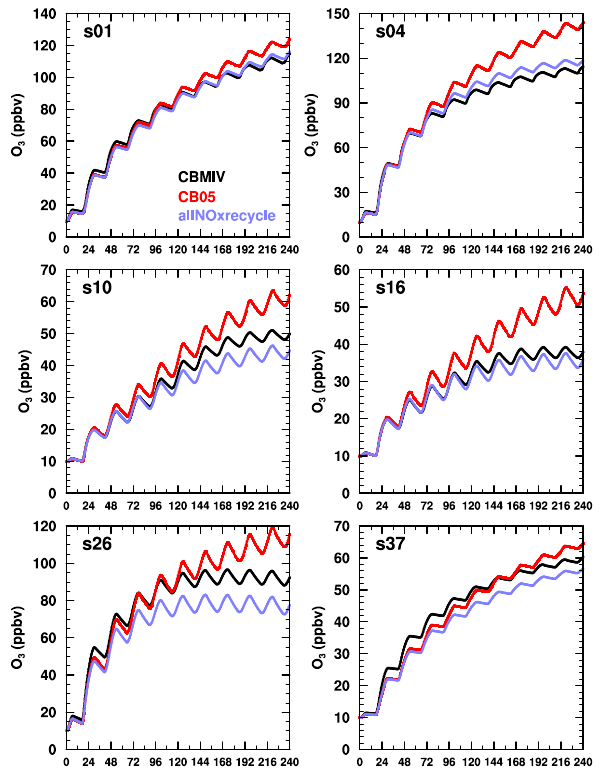
Figure 9 . Example scenario results for sensitivity test xNTRrecycle . Ozone mixing ratios 2 Fig. 9. Example scenario results for sensitivity test xNTRrecycle. (ppbv) for the base CB05 (red), base CBMIV (black) and sensitivity test xNTRrecycle (violet) 3 Ozone mixing ratios (ppbv) for the base CB05 (red), base CBMIV over the 240 hr simulation period. 4 (black) and sensitivity test xNTRrecycle (violet) over the 240h sim- 5 ulation period.